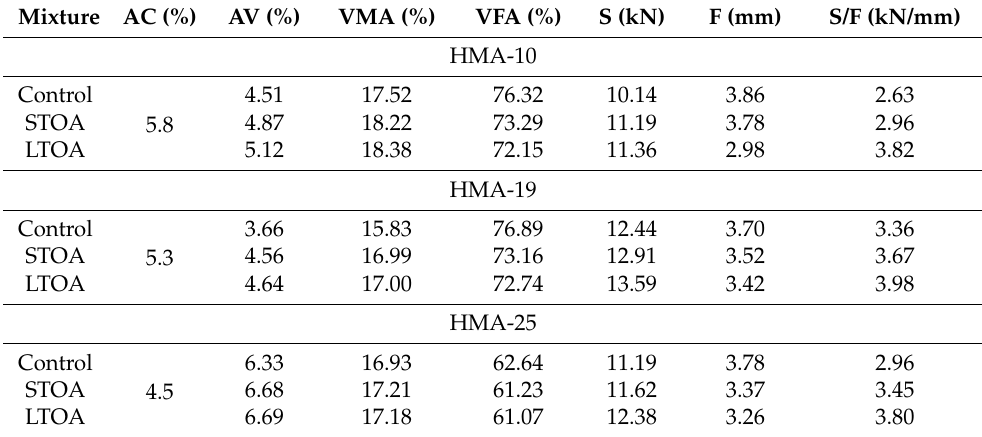
Table 1. Marshall test